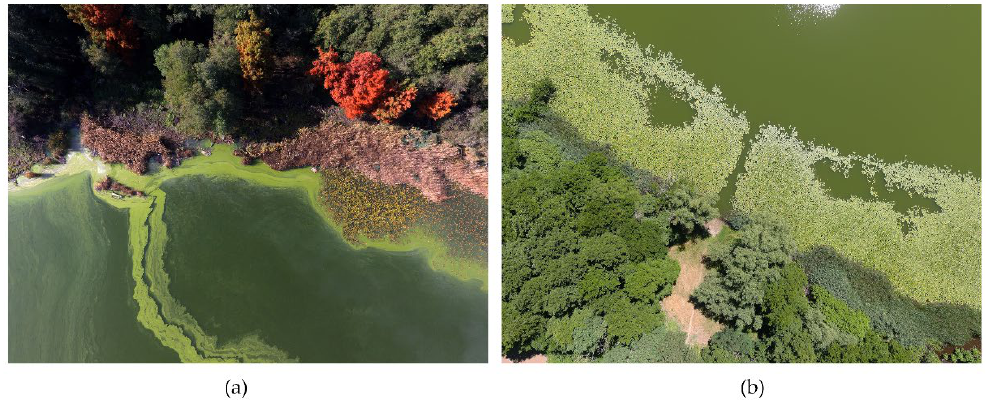
Figure 9. Algal blooming acquired by UAV.